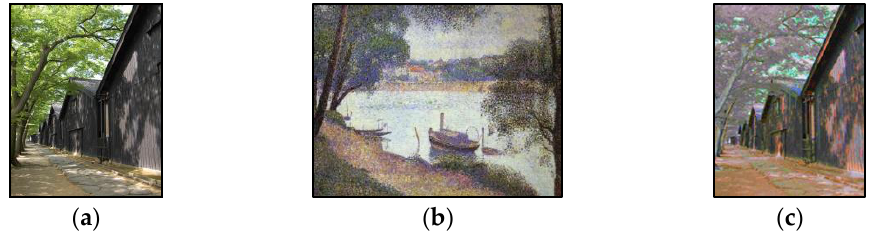
Figure 5. Image samples, ( a ) source image, ( b ) oil painting image, ( c ) image after color conversion.